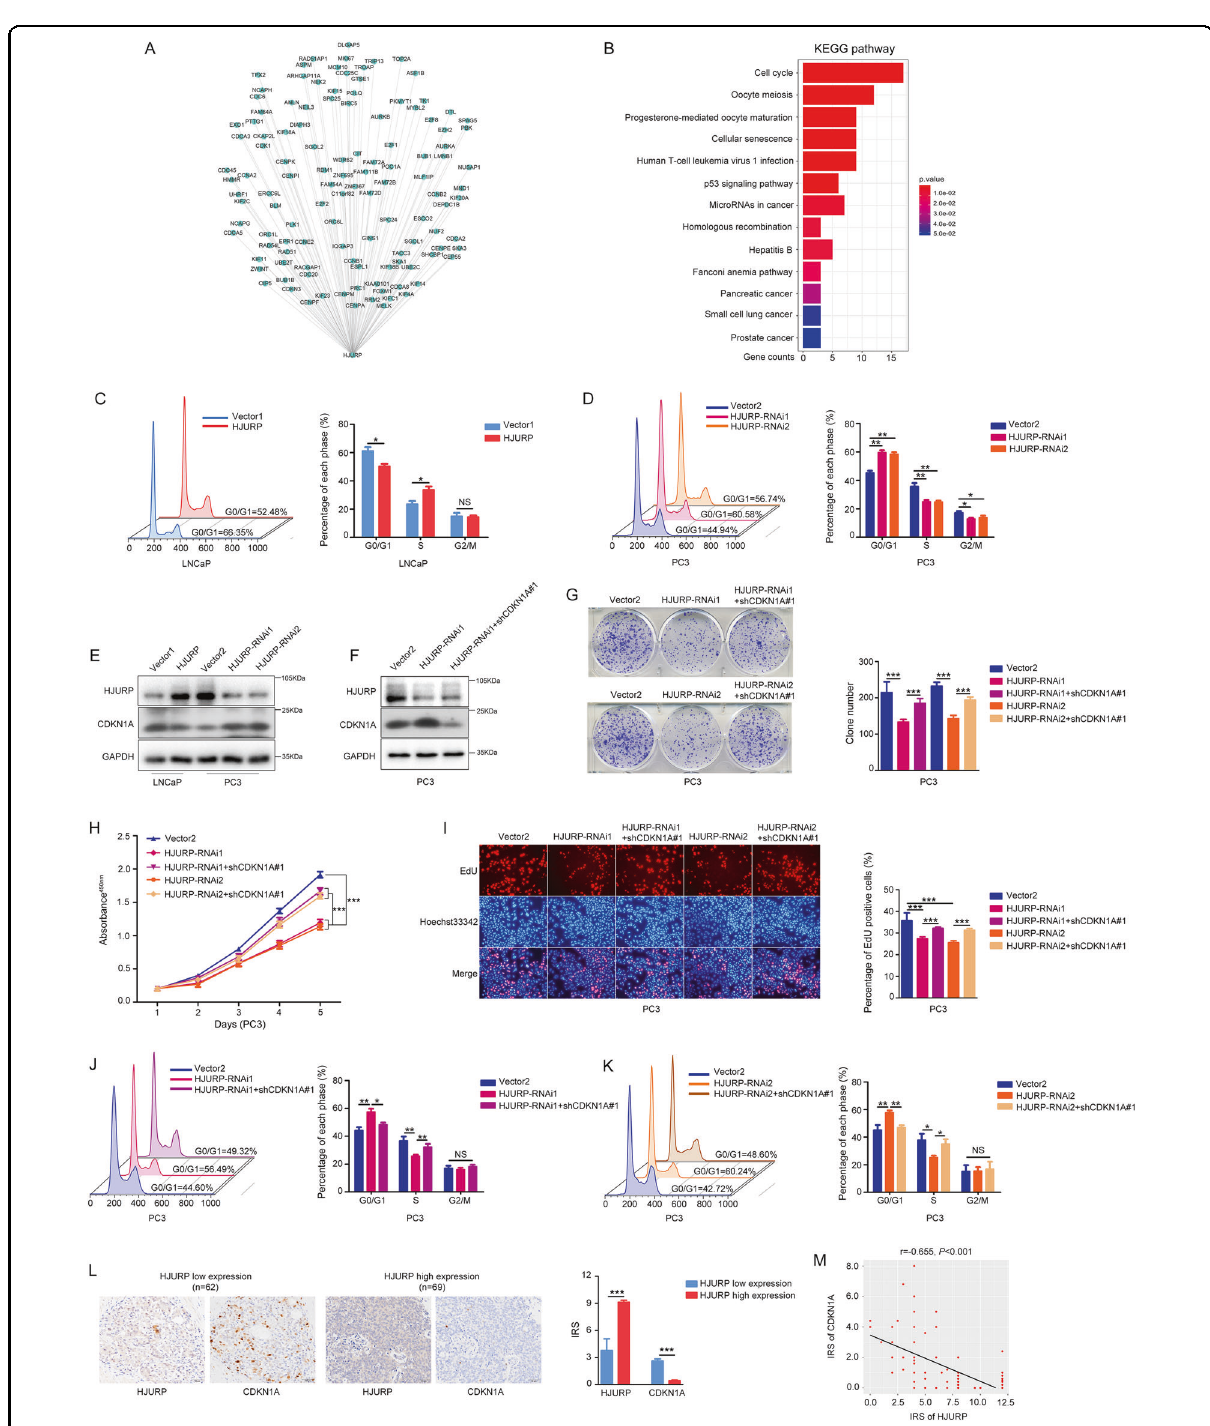
Fig. 4 HJURP inhibits CDKN1A to promote the G1/S phase transition. A Correlation analysis showed that 119 genes were highly correlated with HJURP ( r ≥ 0.06, P < 0.05). B KEGG enrichment analysis of HJURP and its highly correlated genes. C , D Flow cytometry used to measure the proportion of cells in various phases of the cell cycle in HJURP -overexpression ( C ) and -knockdown ( D ). E Western blotting quanti fi ed CDKN1A expression after HJURP- overexpression or -knockdown in PCa cells. F Western blotting results of CDKN1A knockdown ef fi ciency. G – K CDKN1A knockdown signi fi cantly reversed changes in clonogenic potential ( G ), cell viability ( H ), proliferative capacity ( I ), and cell cycle ( J , K ) in PC3 cells caused by HJURP inhibition. L Representative IHC staining of HJURP and CDKN1A in different Gleason grade PCa tissues from our hospital ( n = 131, scale bar: 50 µm; magni fi cation: ×200). M HJURP and CDKN1A protein expression are highly negatively correlated in PCa ( n =